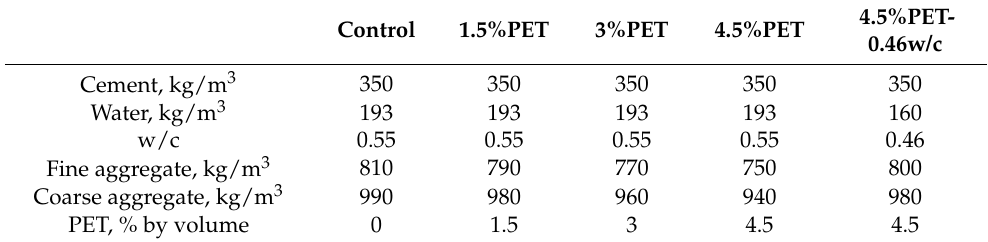
Table 1. Typical PET-modified concrete